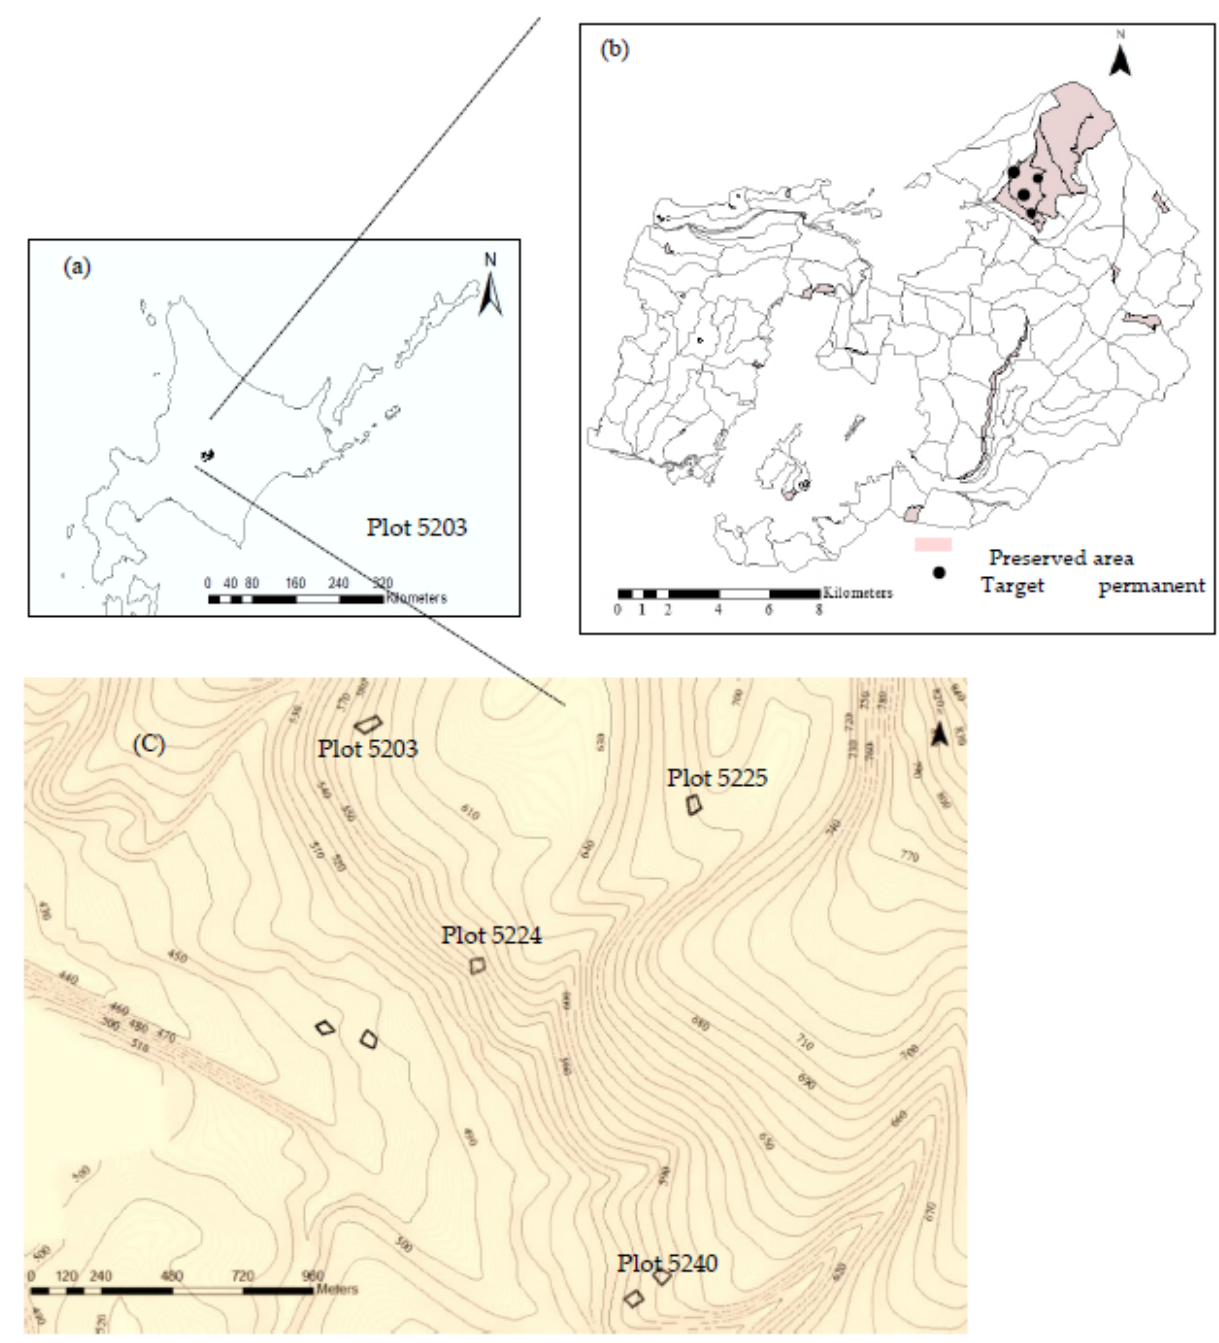
Figure 1. Study area and selected plots. ( a ) University of Tokyo Hokkaido Forest (UTHF); ( b ) tar ‐ geted permanent plots of the persevered area; ( c ) contour map of surrounding of the selected